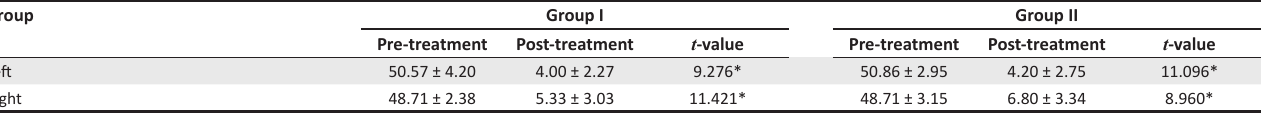
TABLE 3: Mean ± SE values of fetlock joints (degrees) in knuckling calves.